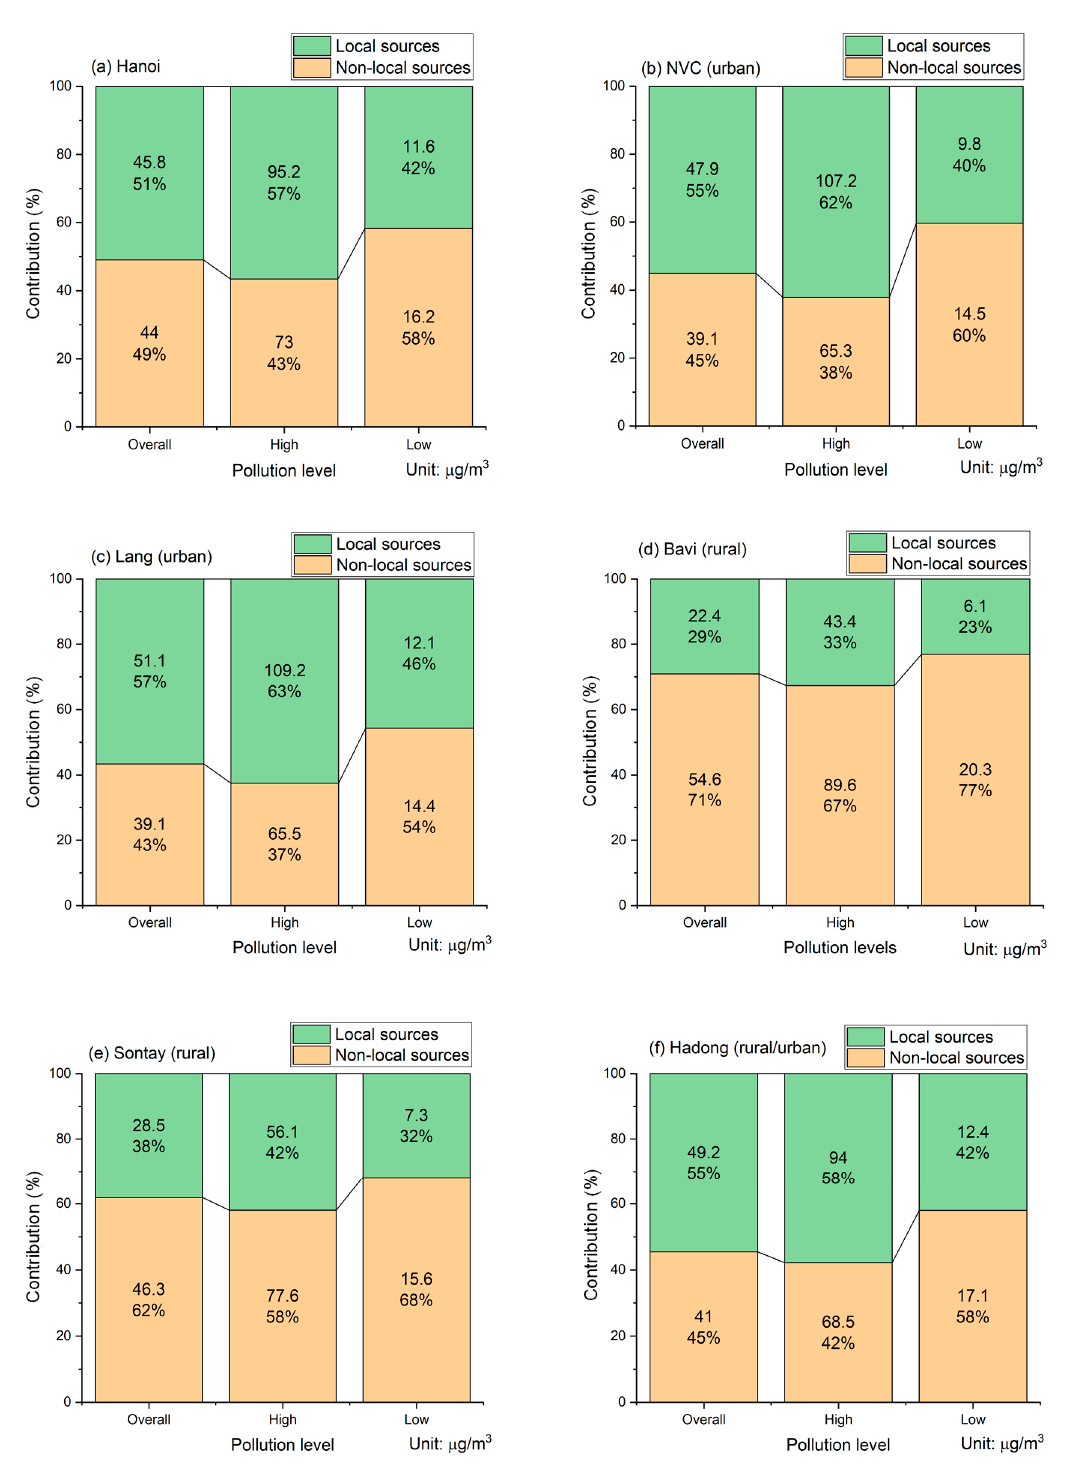
Figure 9. Relative contributions of local and non-local emission sources to PM 2.5 concentrations at three pollution levels: overall, high, and low. Contribution averaged across Hanoi ( a ) and those deduced from the grid points closest to five stations used in this study: ( b ) Lang (urban), ( c ) NVC (urban), ( d ) Bavi (rural), ( e ) Sontay (rural), ( f ) Hadong (rural/urban).